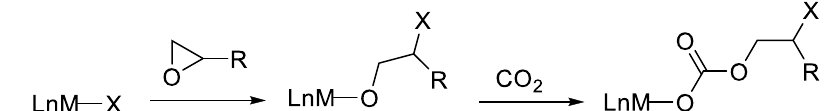
Fig. 5. Initiation of General coordination – insertion mechanism for the synthesis of PCs by ROCOP of CO 2